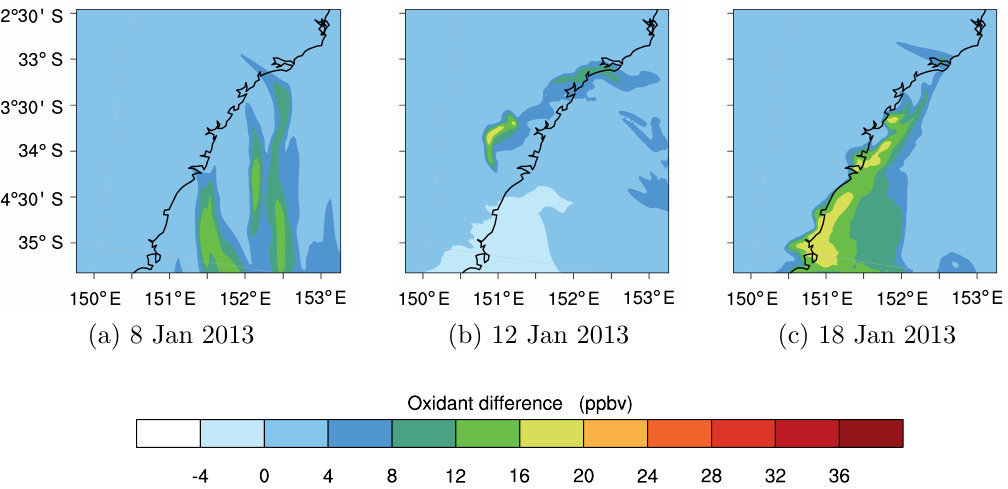
Figure 15. Simulated difference between O x from standard run and O x from average temperature run (STD_ET-AVG_T).